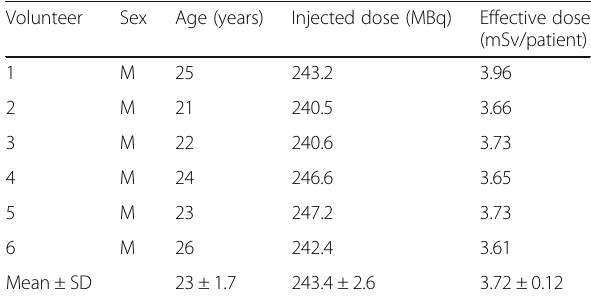
Table 1 Subject characteristics and injected radioactivity of